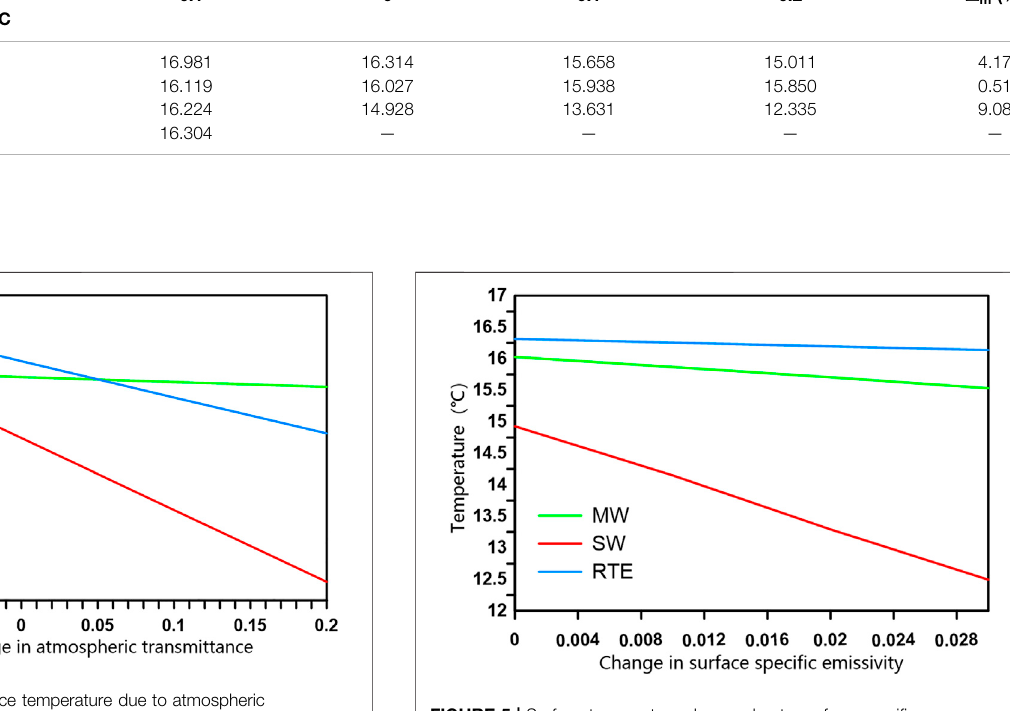
FIGURE 5 | Surface temperature change due to surface speci fi c emissivity error.